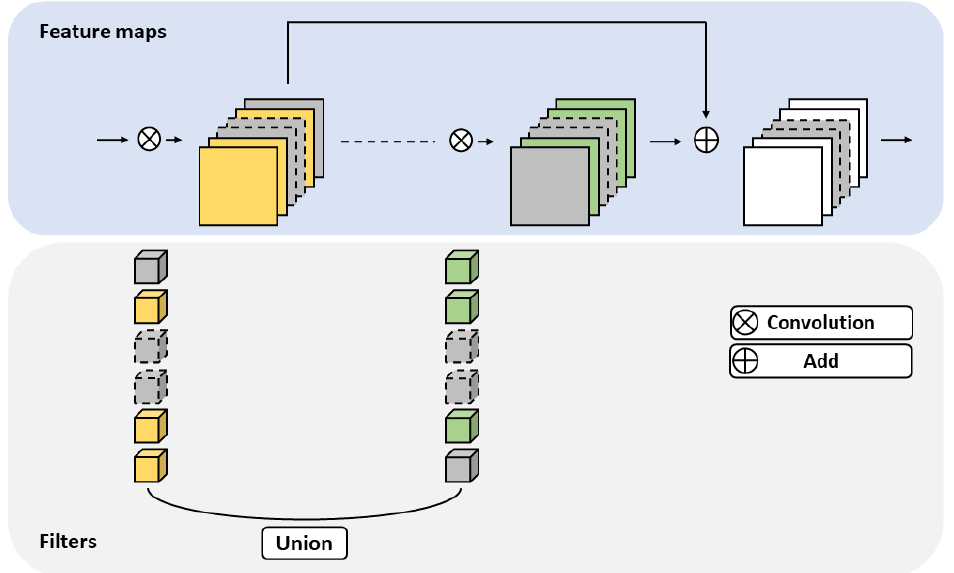
Figure 2. Overview of reconstruction method for residual blocks. The blue background represents feature maps of the residual blocks and the gray background represents the filters of the residual blocks. Each zero-value filter or feature map is represented in gray. Yellow and green filters represent the filters remaining after pruning. Yellow and green filters are used during union operations. Dashed items are those removed after